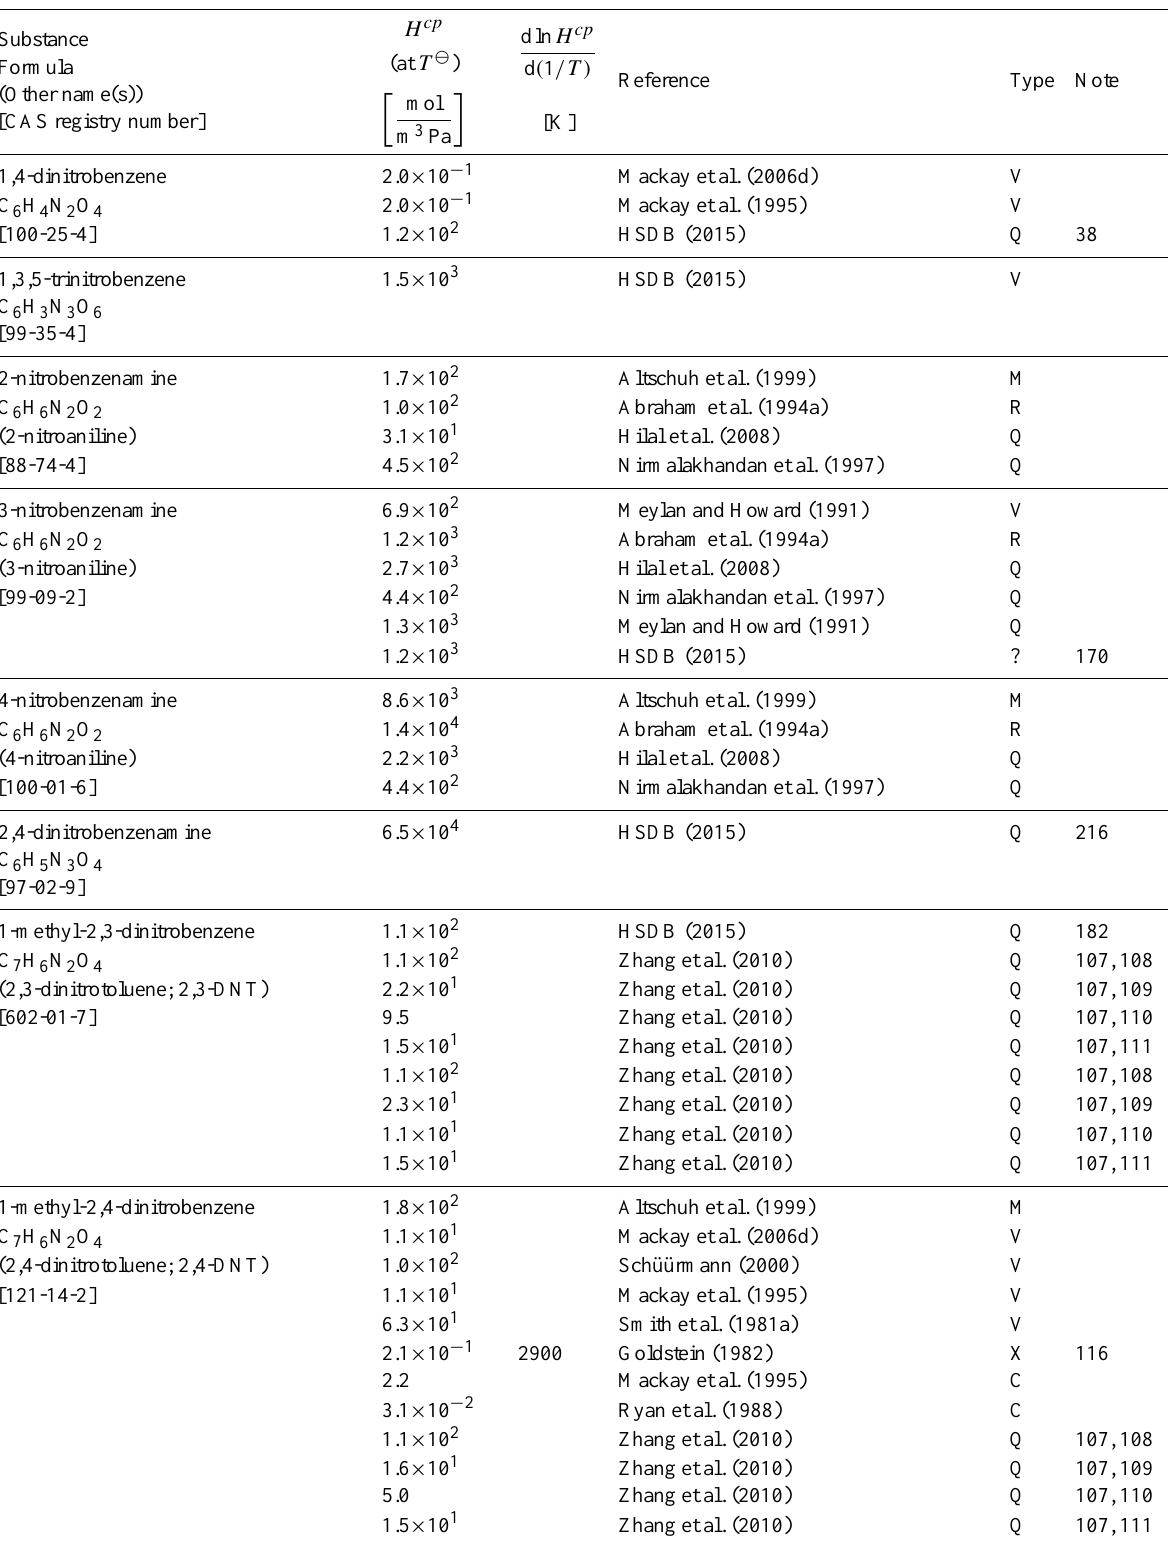
Table 6: Henry’s law constants for water as solvent